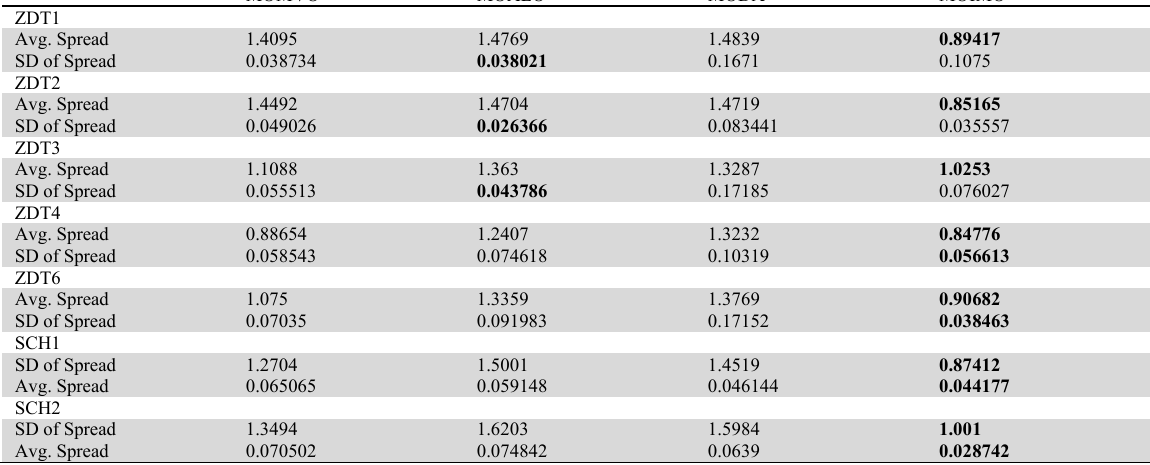
Results of the multiobjective algorithm (using spread) on the unconstrained test functions